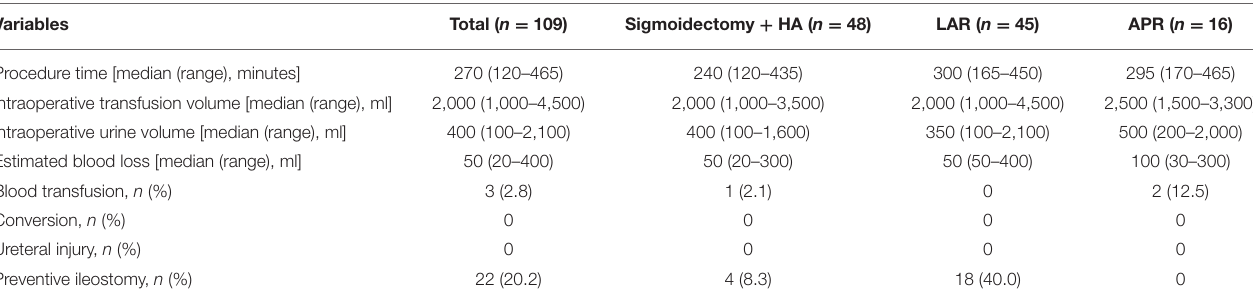
TABLE 2 | Intraoperative outcomes of total